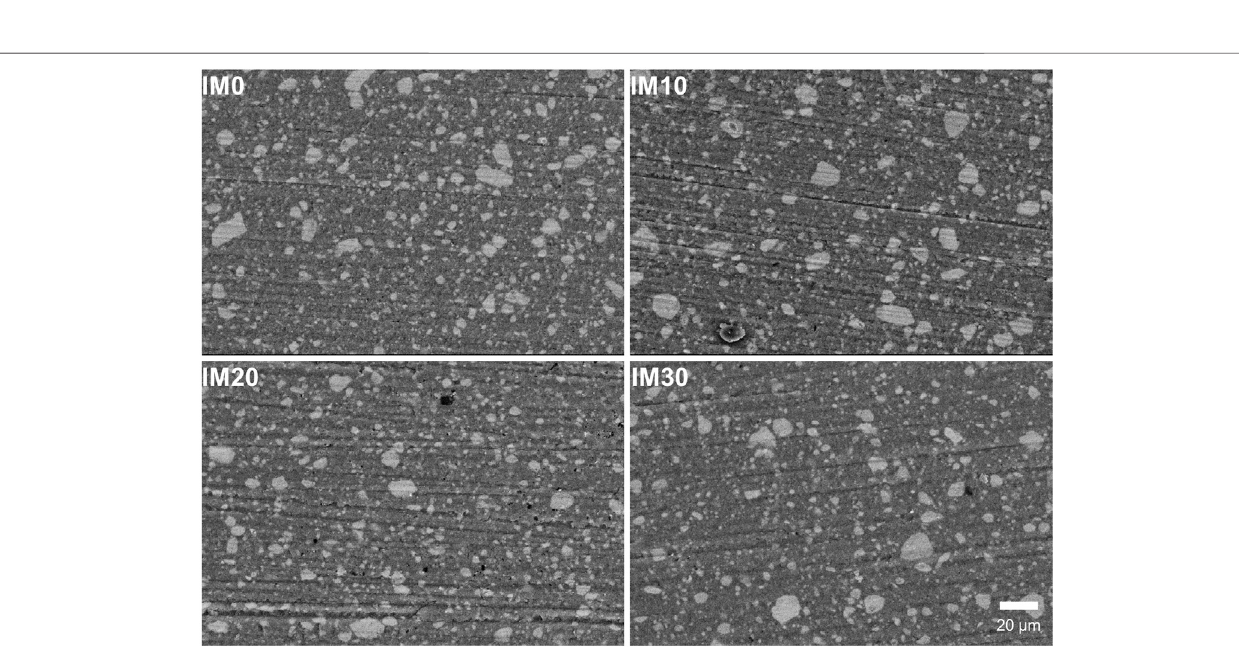
FIGURE 3 | Representative backscattered mode SEM images of the different nanocomposites. Brighter spots indicate micron-sized agglomerates of nHA particles. Dispersion and agglomerate size and shape were consistent between the groups.